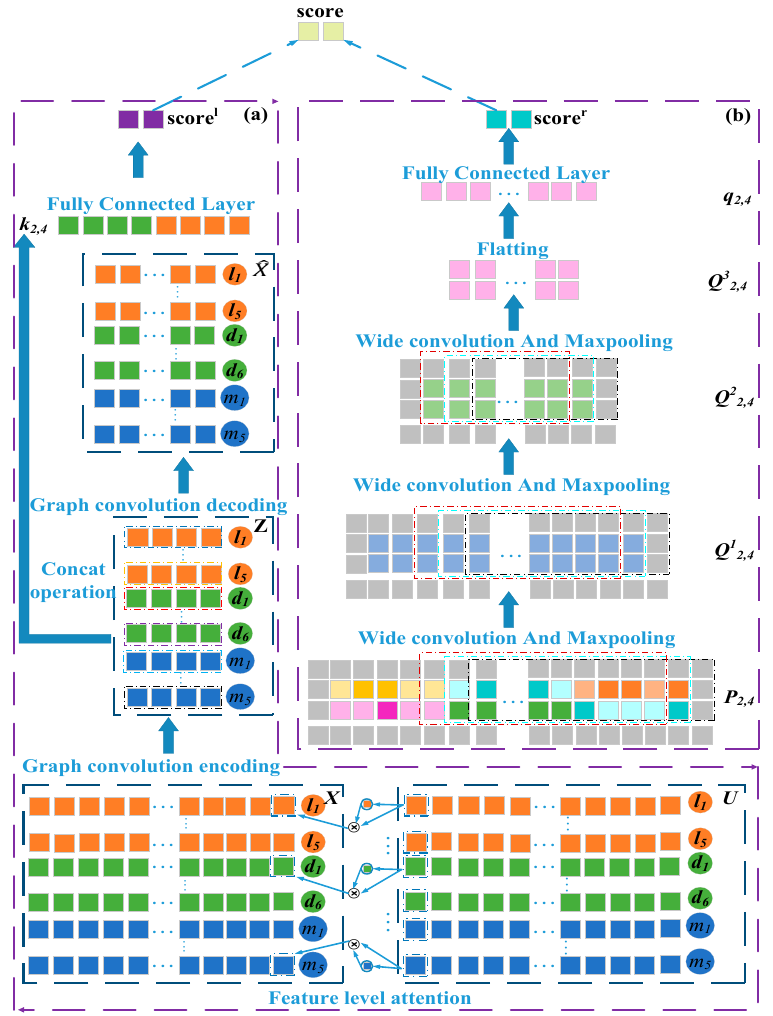
Figure 2. Overall model structure. ( a ) Establish the attention mechanism at the feature levels and the autoencoder based on graph convolution. ( b ) Construct the convolutional and pooling